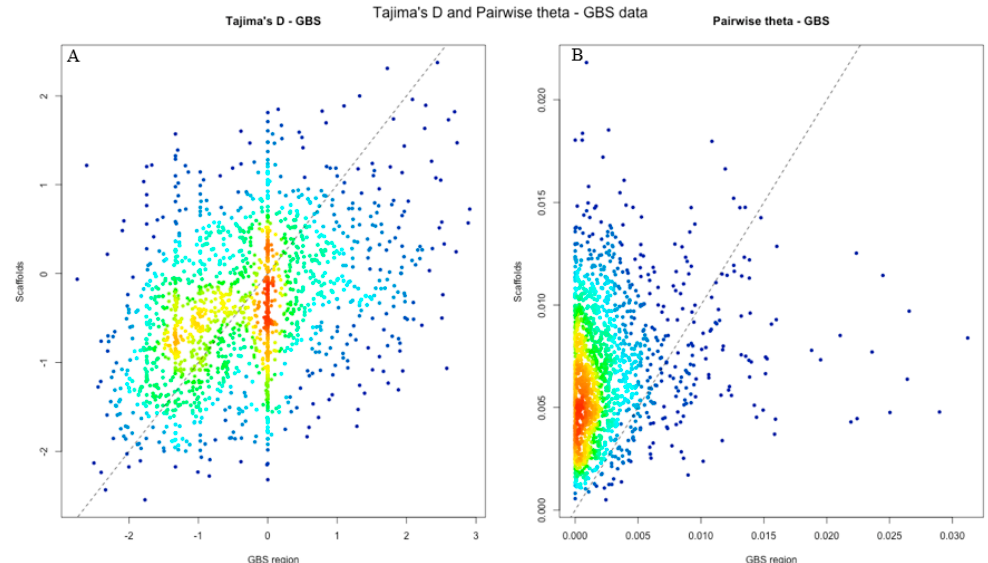
Figure 3. ( A ) Tajima’s D and ( B ) pairwise theta (nucleotide diversity) in the GBS data. Red indicates the highest number of data points and dark blue the lowest.